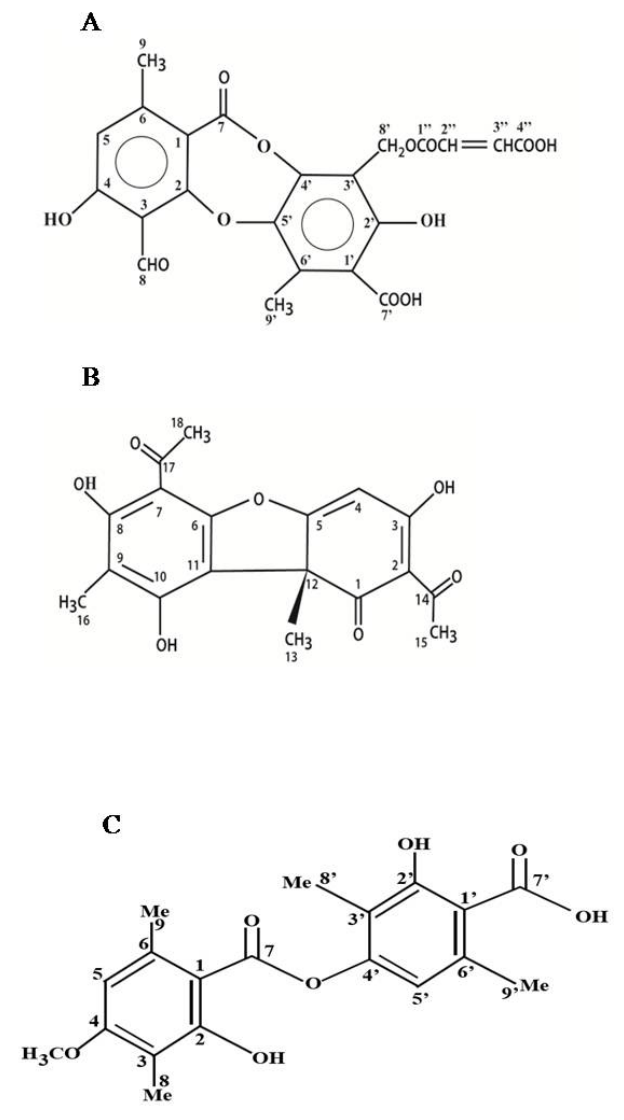
Fig 3 . Chemical structure of purified substances according to spectroscopic analysis. A: fumarprotocetraric acid (FUM); B: usnic acid (USN); C: barbatic acid (BAR). Numbers refer to carbon of the